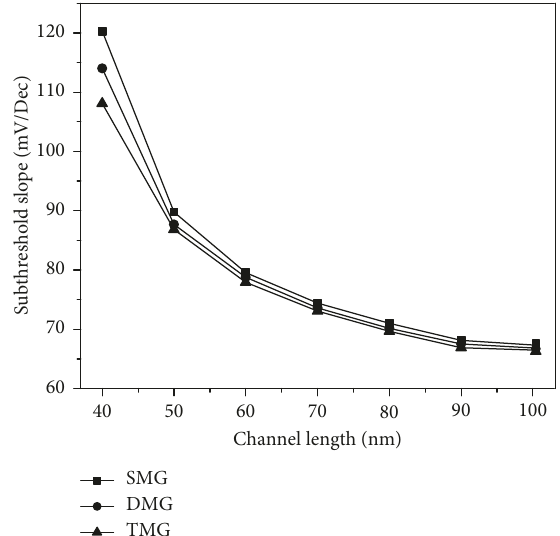
Figure 12: Subthreshold slope at a different channel length for SMG, DMG, and TMG Re-S/D SOI MOSFET.